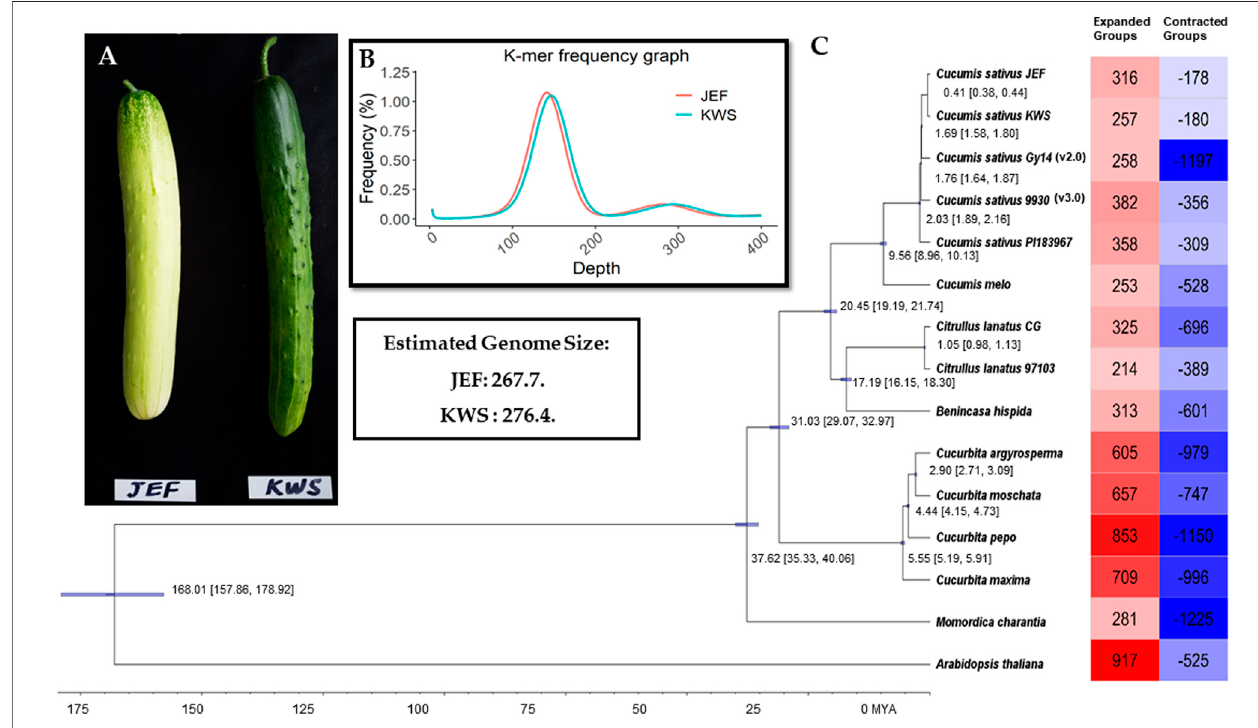
FIGURE1| Summaryofthesequencing. (A) .Cucumberfruitsofthevarietiessequencedinthisarticle. (B) .Genomesizeestimation. (C) .Phylogenetictreefromthe single-copy genes along with summaries of gene gain and loss.